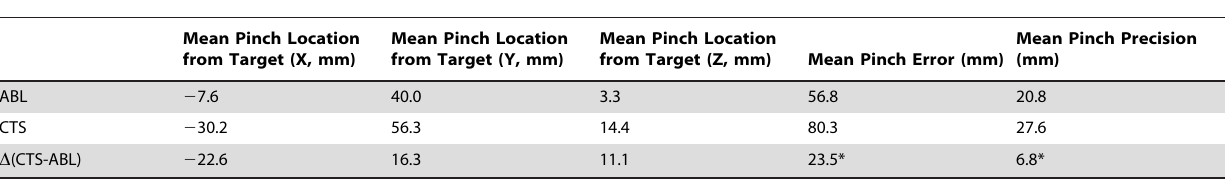
Table 1. Global Pinch Contact Location Metrics.